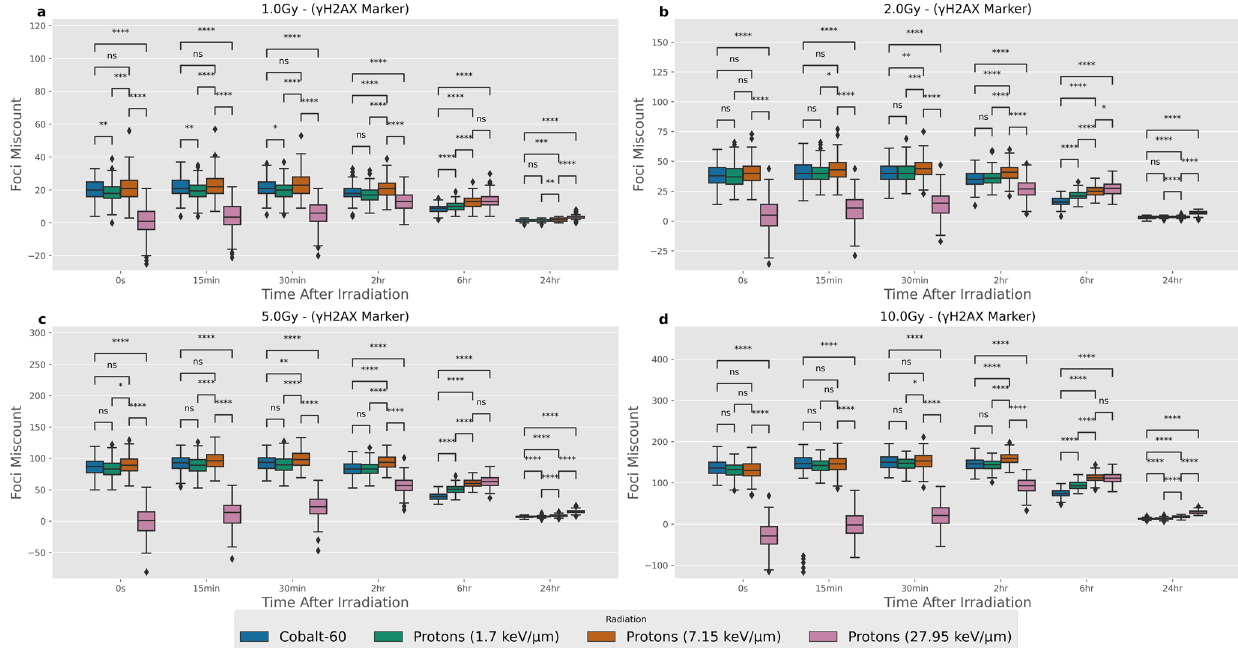
Fig. 2 Distributions of miscounting between foci detected and the number of DSBs within the central microscope slice of the cell nucleus when using an γ -H2AX marker of fl uorescence. Each panel is the same four radiation types and six-time points being compared for different radiation doses, where a – d correspond to 1.0, 2.0, 5.0, 10.0 Gy respectively. Error bars correspond to 1.5 times the interquartile range in either direction. Mann – Whitney test between different radiation types at each time point and dose to highlight statistically signi fi cant differences. p values have been adjusted using the Bonferroni correction. Signi fi cance notation refers to the following thresholds: ns = p > 0.05, * p > 0.01, ** p > 1e − 3, *** p > 1e − 4, **** p < 1e − 4. There are 200 samples for each box-plot. All microscope images have been emulated using the Airyscan ×63 point spread